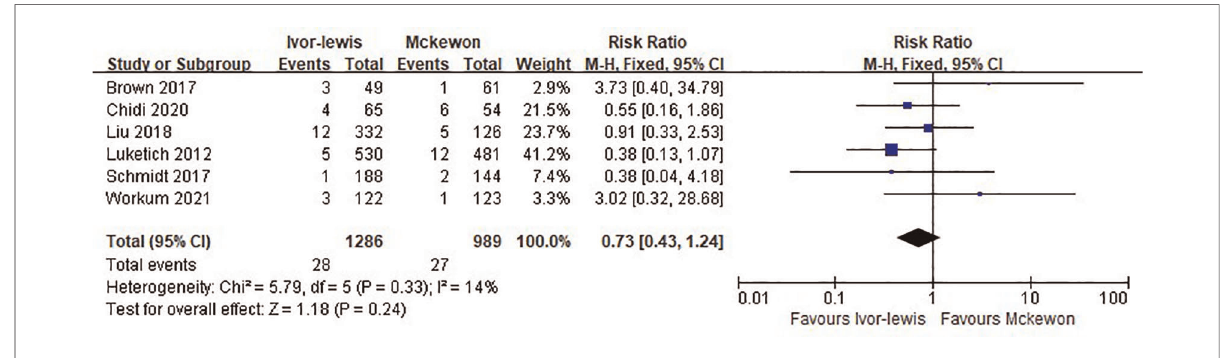
FIGURE 4 Forest plots of the 30-day mortality analysis in Ivor Lewis procedure vs. McKeown